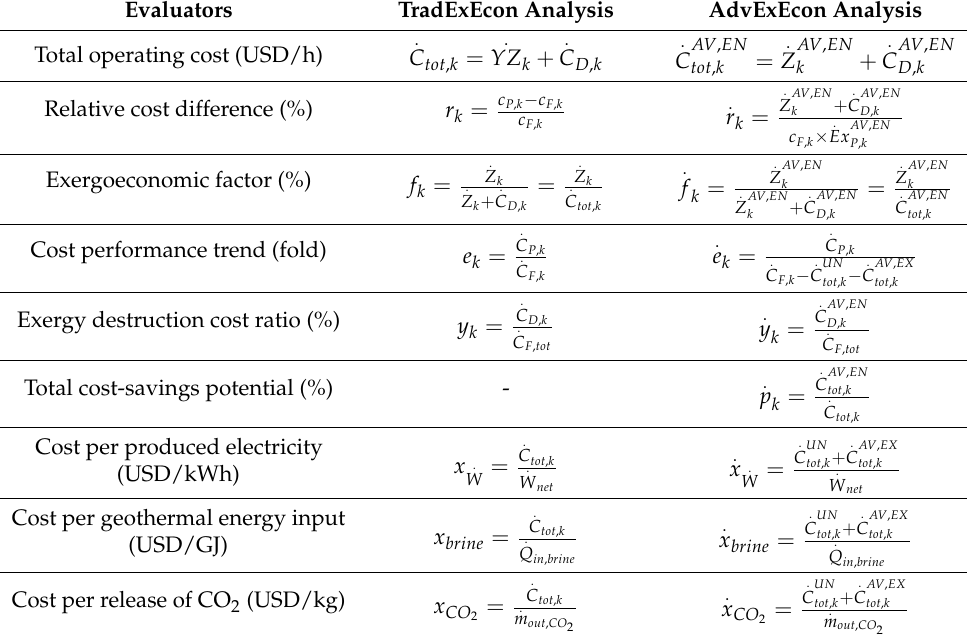
Table 3. The performance markers of the system for the TradExEcon and AdvExEcon analyses. Evaluators TradExEcon Analysis AdvExEcon